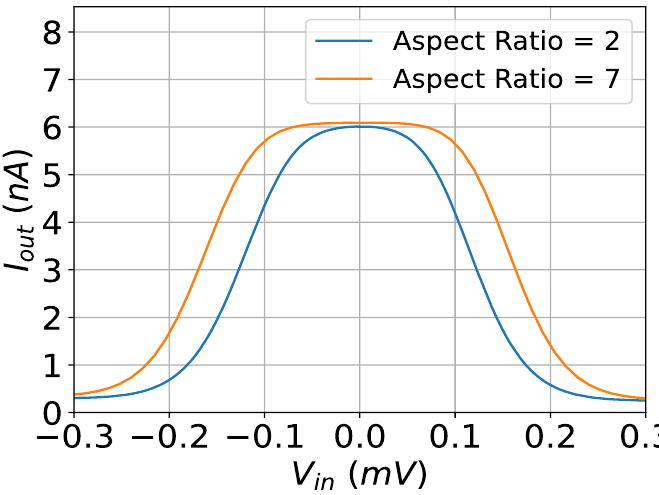
Figure 2. The output current of the modified (orange) and the baseline (blue) bump circuits. The con- trolling parameters for both circuits are set to V r = 0 V, V c = 150 mV, and I b ias = 6